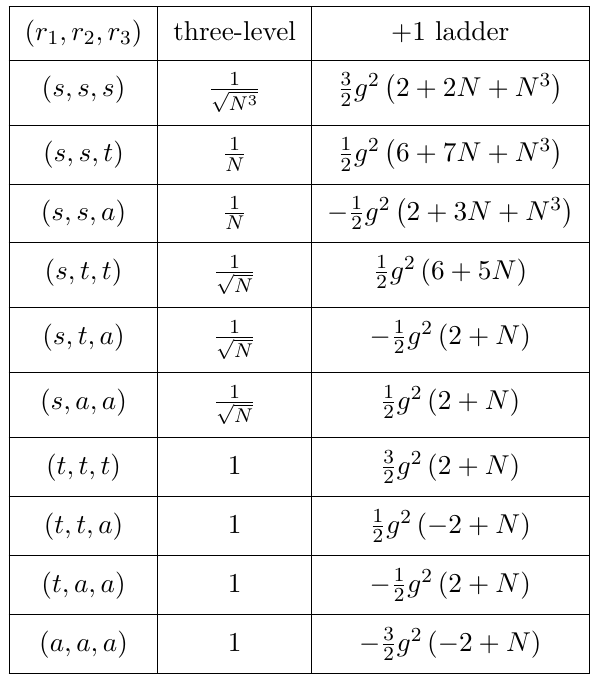
Table 1 . Coefficient multiplying the group tensor structure and the spacetime factor for each three point function h ΦΦ O i . The second row is the overall three level coefficient. The third row ( r 1 ,r 2 ,r 3 ) must be intended as a correction and should be multiplied by the three level coefficient to get the correct factor. The bilinear normalization is chosen such that their 2pt function is N